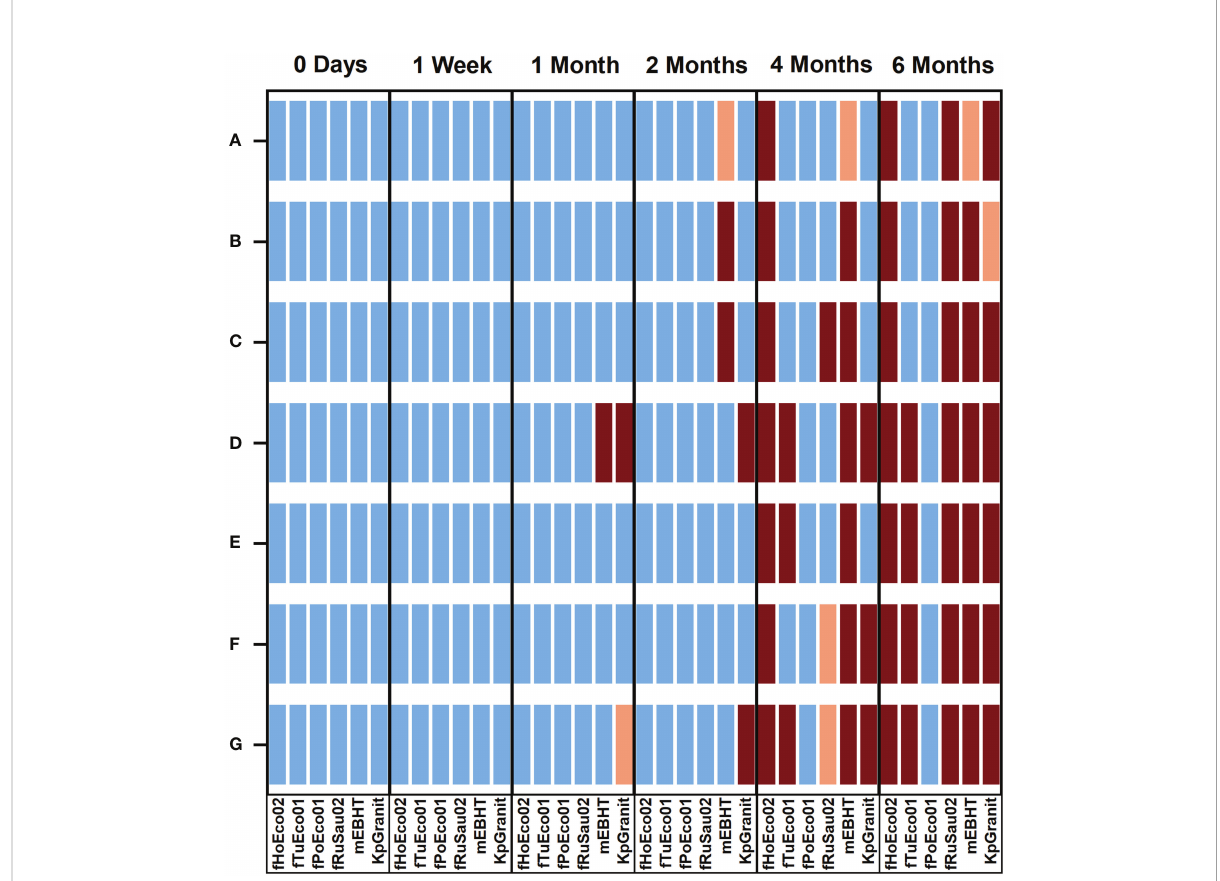
FIGURE 7 Overview of the stability of phages in ready-to-screen PST plates. Phages fHoEco02, fTuEco01, fPoEco01, fRuSau02, mEBHT, and KpGranit stored with GrowDex hydrogel and with either 3.3% (A) , 2.0% (B) and 1.0% (C) trehalose, 1.0 mg/ml (D) , 0.2 mg/ml (E) hyaluronic acid, and 0.01% gelatin (F) , or without stabilizer (G) compositions on ready-to-screen plates as 10 µl droplets for six-months. Ready-to-screen plates were measured using the optimized liquid growth assay protocol developed in this study immediately following plate preparation, as well as after 1 week, 1, 2, 4, and 6 months of storage time. Bacterial growth was followed by measuring optical density at 600 nm for fi ve hours. All the measurements were performed in triplicate, and mean and SD values were calculated. Bacterial growth in lysogeny broth without phages served as a control. Result interpretations are color-coded. Blue: Phage was viable. PST gave clear positive results and bacterial growth was < 50% of the control. Orange: Phage was partially viable;. bacterial growth was 50 to 70% of the control. Brown: Phage was not viable; bacterial growth was > 70% of the